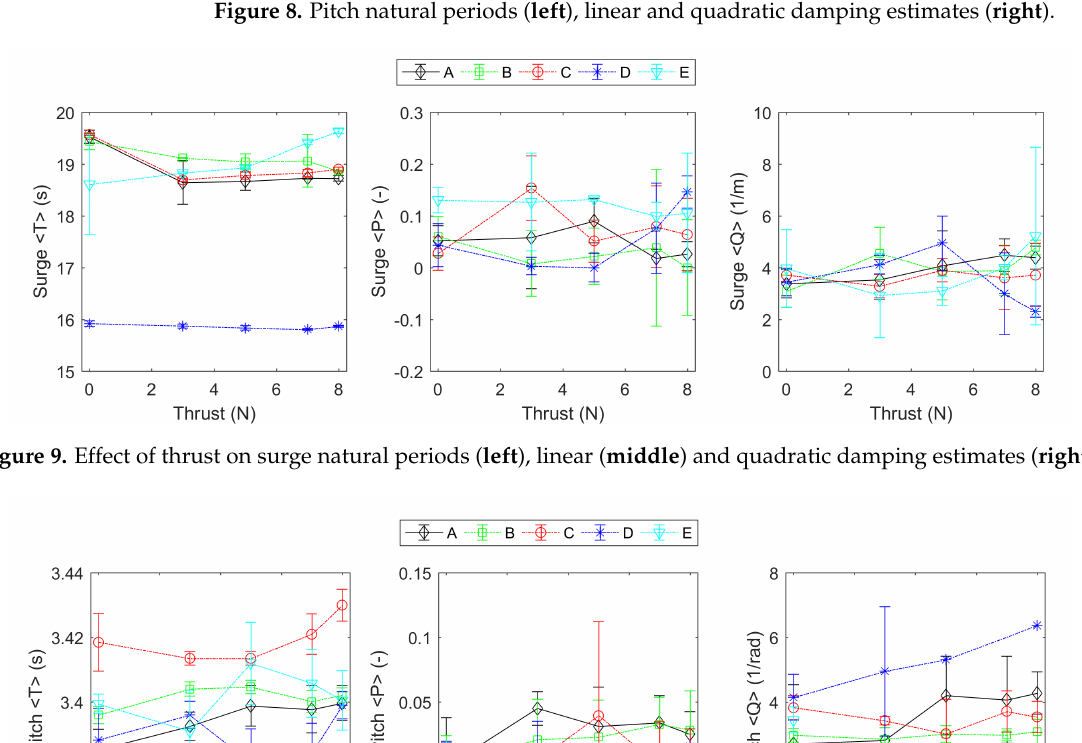
Figure 8. Pitch natural periods ( left ), linear and quadratic damping estimates ( right ).